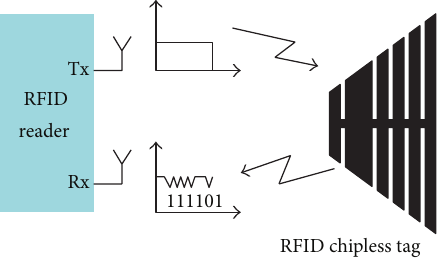
Figure 2: Principle of operation.